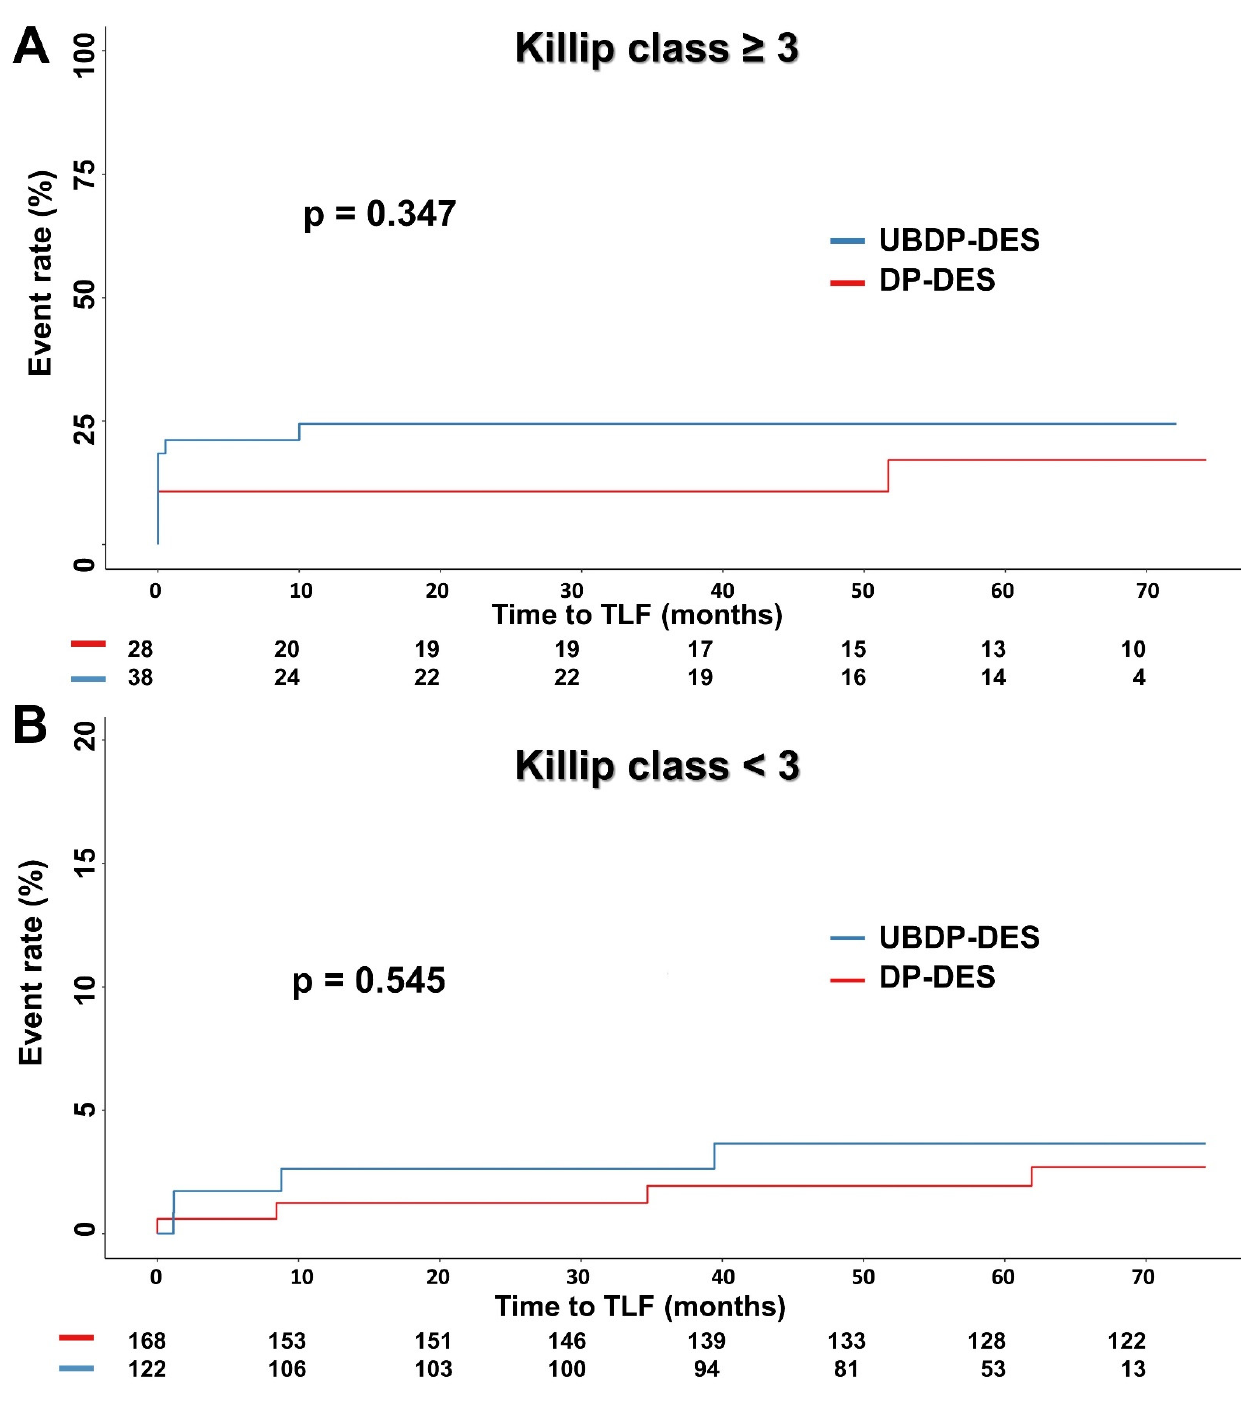
Figure 4. Kaplan–Meier survival curves of TLF in subjects presenting ( A ) with or ( B ) without Killip class ≥ 3.